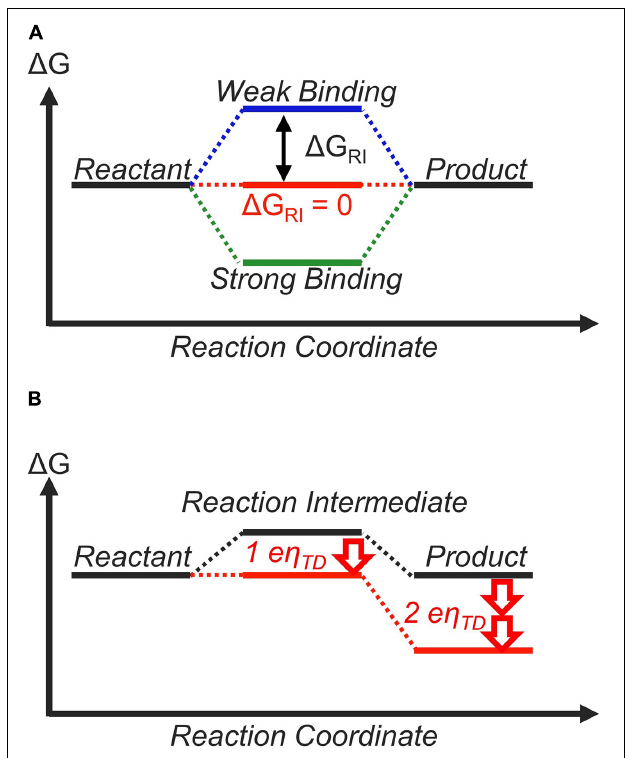
FIGURE 1 | The thermodynamic free-energy landscape of a catalytic reaction with one reaction intermediate. (A) indicates the free-energy landscape for different binding strengths ( (cid:49) G RI ) of the reaction intermediate. (B) shows the free-energy landscape for a catalyst that binds the reaction intermediate weakly ( (cid:49) G RI > 0 at equilibrium, black). By applying an overpotential of η = η TD , all elementary reaction steps become thermoneutral or downhill in free energy